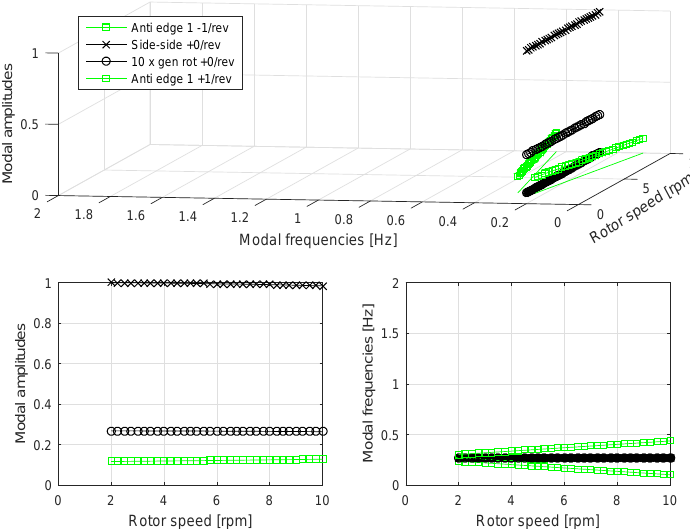
Figure 17. Harmonic modal components for the two-bladed turbine mode dominated by tower side–side motion. Plot layout as in Fig.